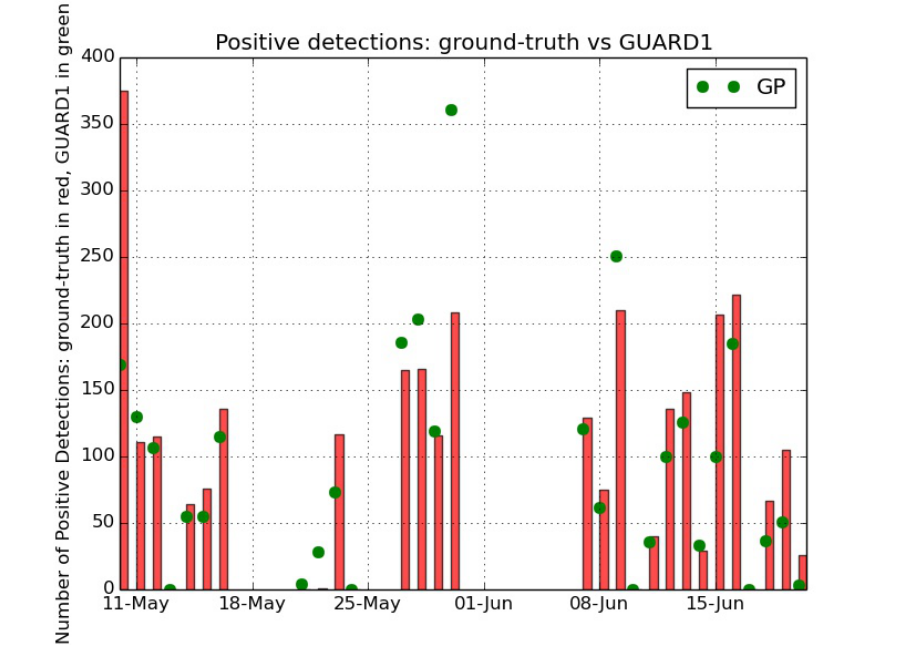
Figure 7. The recognition results of the GP method applied on the whole image time series collected in the Ligurian Sea during the bloom of gelatinous zooplankton in the period May–June 2013. The time series has been annotated by experts and builds a ground-truth dataset. The vertical red bars represent the number of jellies identified by the biologists in the corresponding day, and the green markers represent the number of jelly specimens recognized by the GP method. The Pearson correlation evaluated in time between the number of identified specimens from the ground-truth and the number of positive detections by the GP algorithm is 0.79.